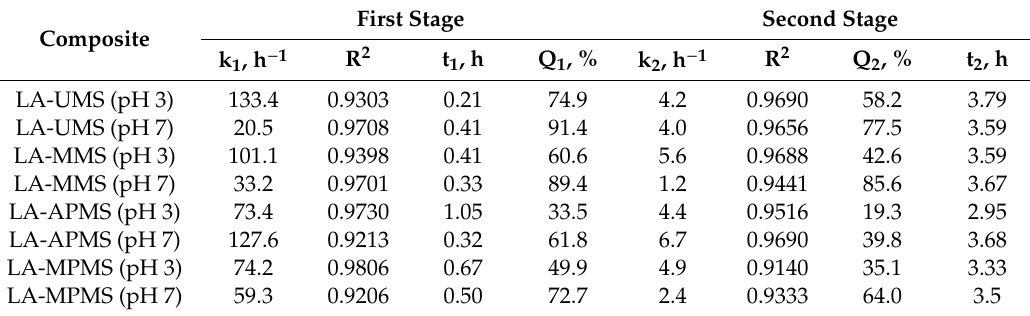
Table 5. Kinetic parameters of degradation LA in